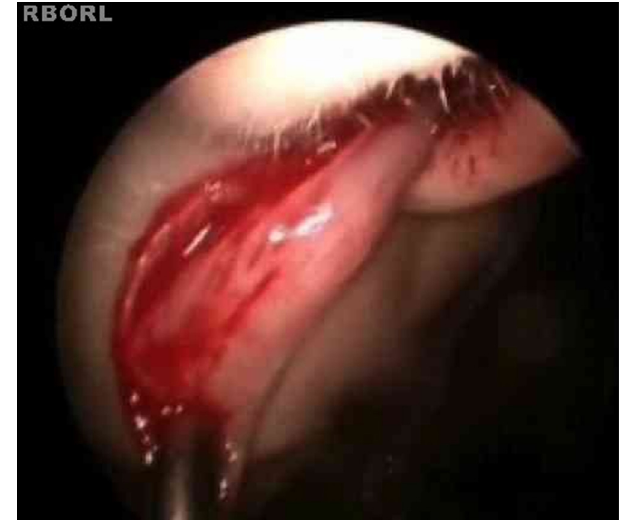
Figure 3 Removal of resected turbinate.